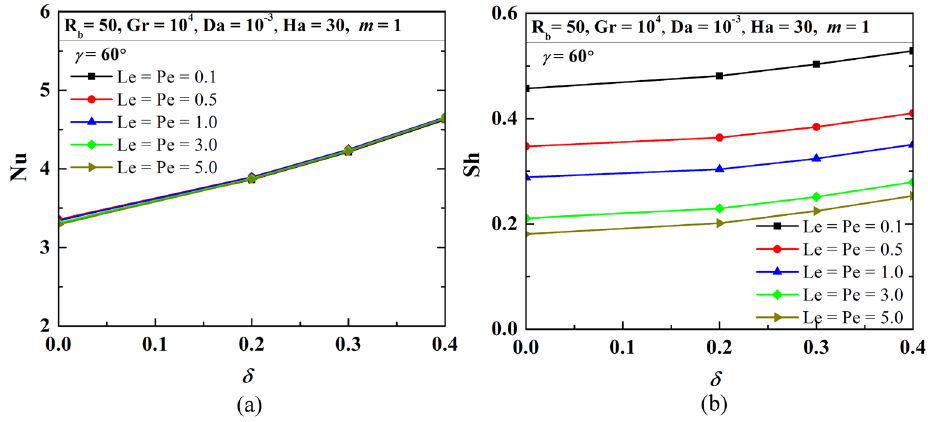
Figure 21. Variations of average Nu ( a ), and Sh ( b ) when R b = 50, Gr = 10 4 , Da = 10 –3 , Ha = 30, m = 1, γ = 60°, changing Pe and Le.